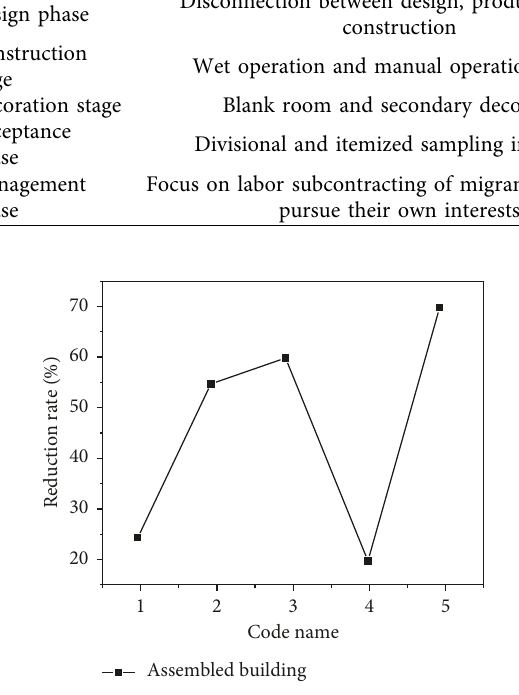
Figure 3: “Four sections and one environmental protection” of prefabricated